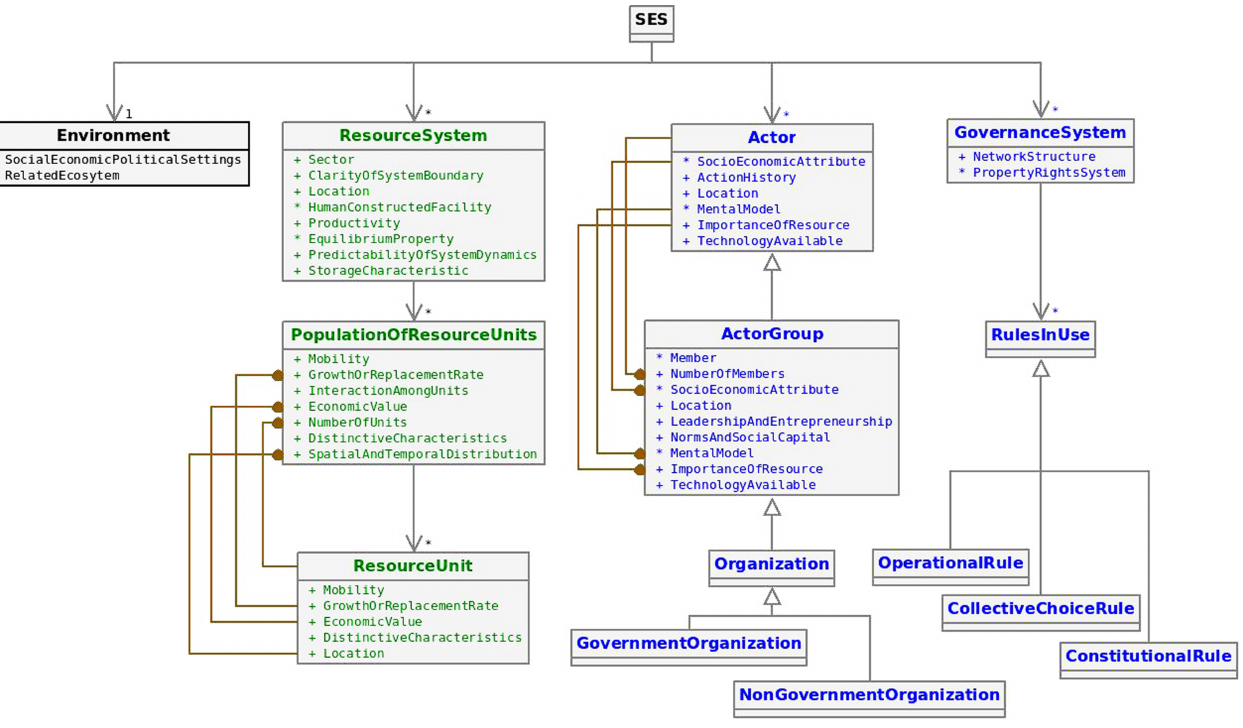
Fig. 3. The refined Ostrom social-ecological system (SES) framework. Boxes denote concepts, black arrows pointing down denote attribution relationships, black open arrowheads pointing up denote subsumption relationships, brown links denote aggregation relationships. A 1 indicates a one-to-one attribution relationship; an asterisk indicates a one-to-many attribution relationship. Concept names are indicated in boldface in the top part of the boxes; attributed variables are listed in the bottom part of the boxes. Process relationships and outcome metrics are not